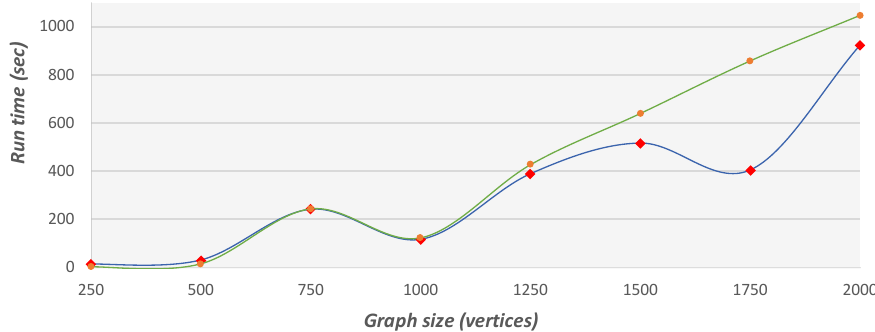
Figure 20. Run time comparison on graphs with different sizes and 0.15 density. This graph presents the run time of the 2-factor approximation method ( green ) and the GA ( blue